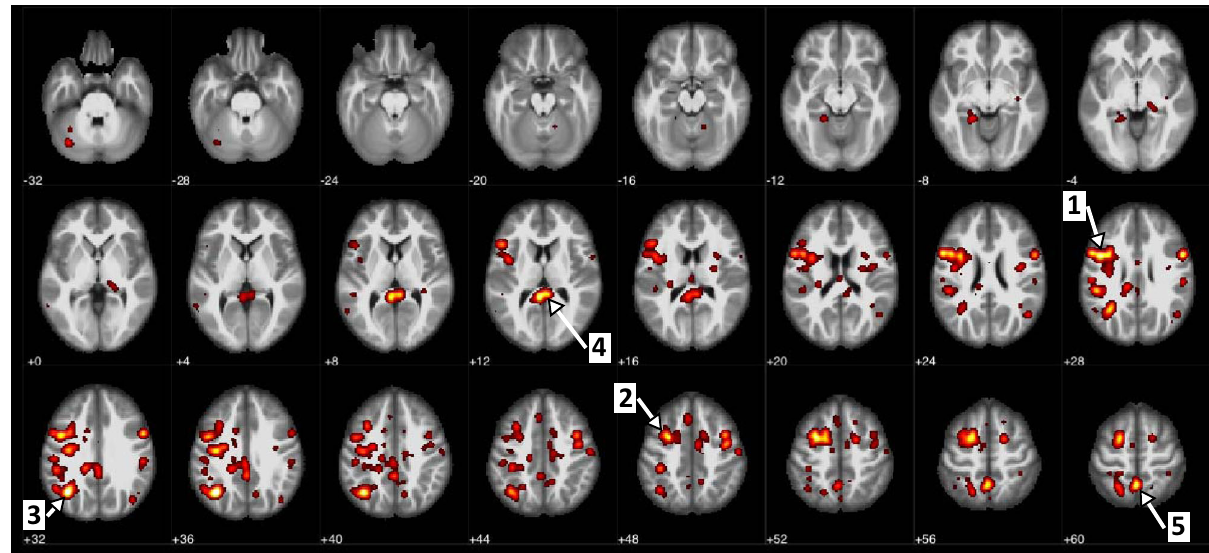
Fig. 1 A stable subset of statistically signi fi cant (Bonferroni-surviving) site-standardized (ss) log-degree features, across 95 data subsets corresponding to leave-subject-out CV. For each data subset, a two-sample t -test was performed to select the subset of features surviving Bonferroni correction. The intersection of all such subsets contains 426 “ stable Bonferroni ” voxels (vs. 700 that survived Bonferroni on the whole dataset but were not necessarily stable). Note that mean values of the site-standardized log-degree, as well as the corresponding log- degree features, at all highlighted voxels, were higher in schizophrenic group than in the control group (see Supplementary Fig. S3). The numbered arrows in the fi gure point to the most-signi fi cant (smallest p -value) largest clusters, which included: (1) left BA6 (precentral gyrus, inferior frontal gyrus); (2) left BA6 (middle frontal gyrus); (3) left BA39 (lateral occipital cortex, superior division); (4) left BA30 (cingulate gyrus, posterior division); and (5) left BA7 (precuneus). Also, see Supplementary Table S5 for the MNI coordinates of the clusters ’ local maxima). For visualization purposes, the original-resolution statistical maps are upsampled (to 2 × 2 × 2 × mm), thresholded based on intensity and cluster size, and smoothed using a Gaussian kernel (5 mm FWHH) in bspmview. 28 The original statistical p -map is provided in supplementary information below Supplementary Table